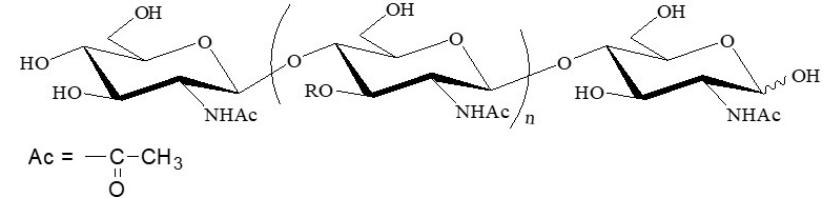
Figure 1. Chemical structure of chitin.